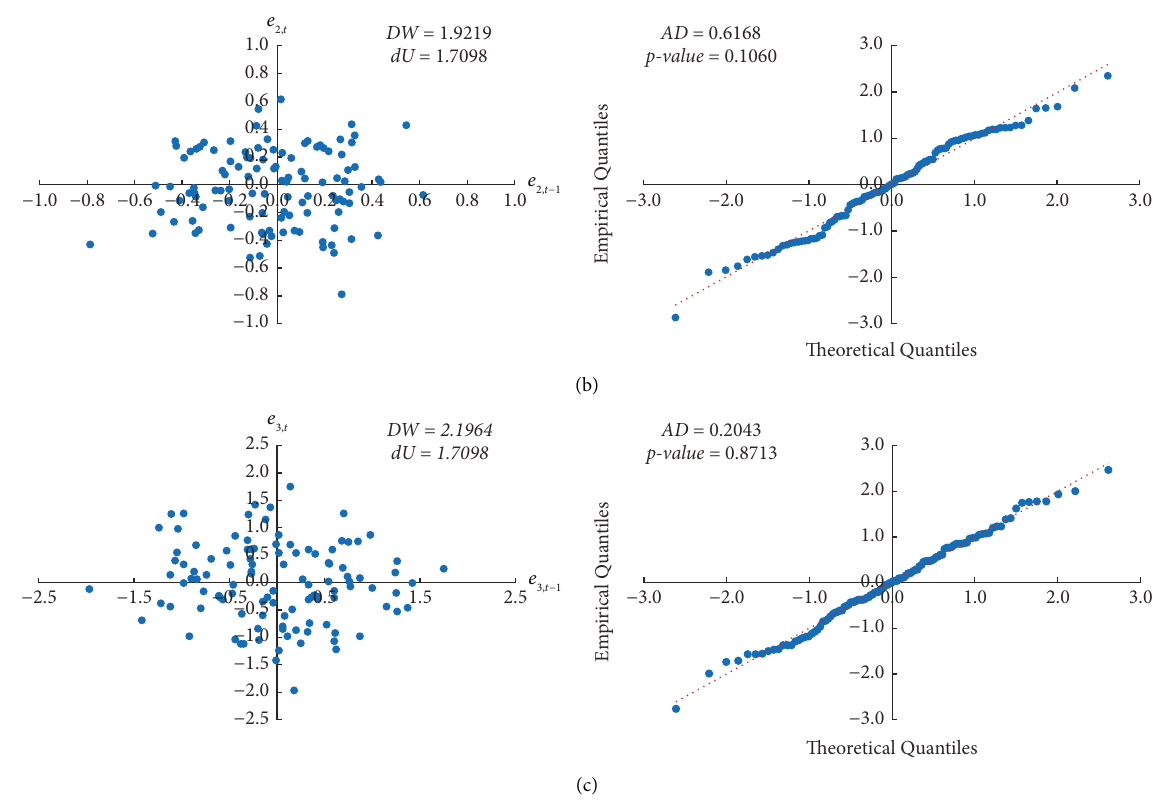
Figure 3: Scatter plot and Q-Q plot of residuals issued by ARIMA model for (a) X